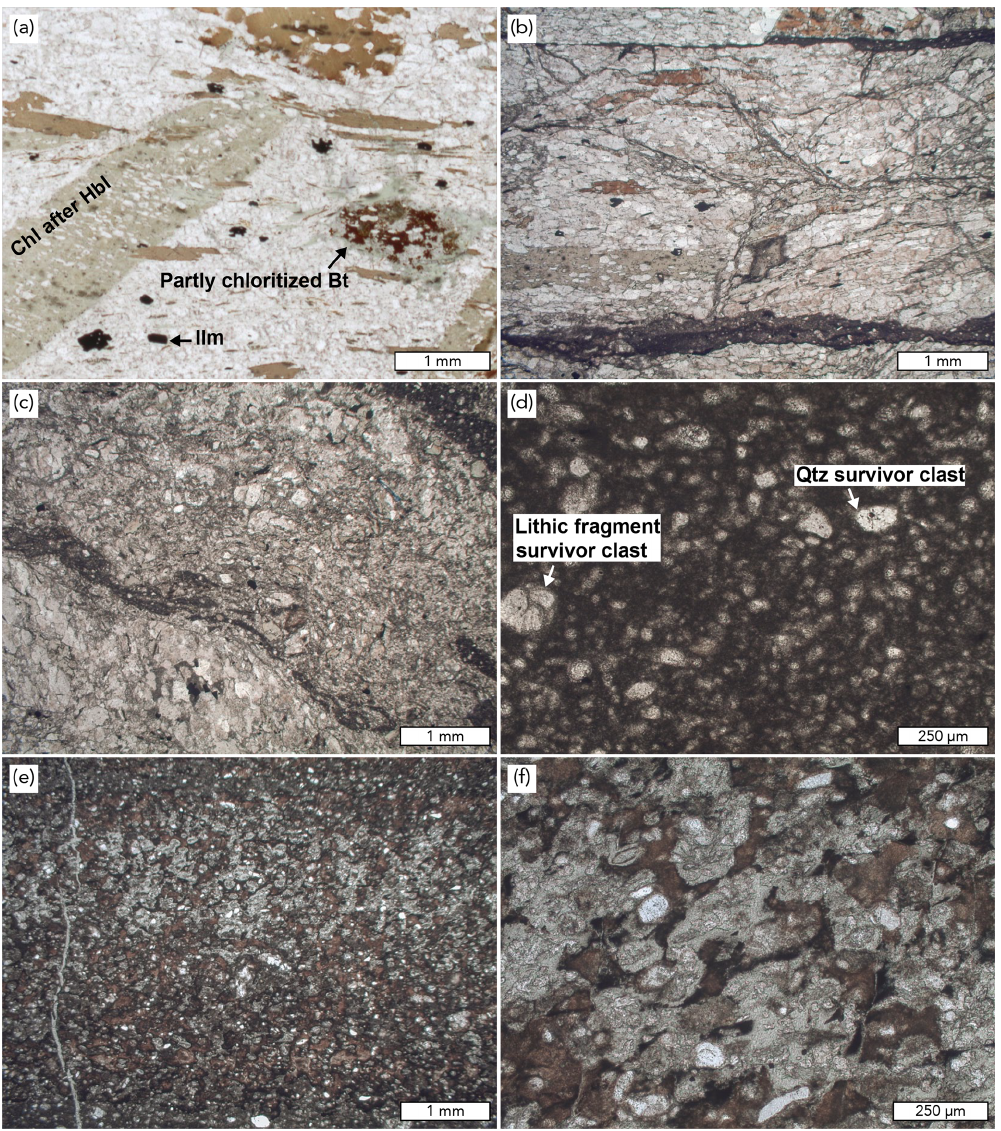
Figure 4. Microstructural appearance of host rock and different fault rock types (plane polarized light). (a) Host rock: foliated micas- chist with fine-grained (50–200µm) quartz + white mica + plagioclase matrix and 1 to 10mm sized porphyroblasts of biotite (fresh: top, partly chloritized: middle right) and pseudomorphs of chlorite after amphibole (left). (b) Brittlely deformed domain in the host rock with multiple fractures filled with cataclasite (center) and/or pseudotachylyte (top and bottom). (c) Cataclastic fault rock: host rock fabric is com- pletely obscured, some lithic fragments remain (bottom left), pseudotachylyte veins occur with patchy and diffuse borders (center, top right corner). (d) Pseudotachylyte: cryptocrystalline matrix containing 20–100µm sized, spaced survivor clasts of quartz and lithic fragments. (e–f) Spherulitic appearance of altered pseudotachylyte at different